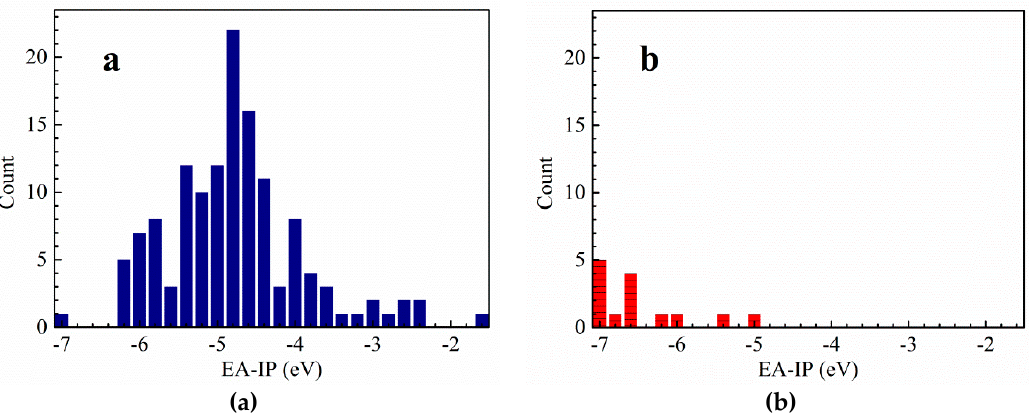
Figure 3. The di ff erence between VEA of the cation and VIP of the anion for common energetic salts ( a ) Figure 3. The difference between VEA of the cation and VIP of the anion for common energetic salts Figure 3. The difference between VEA of the cation and VIP of the anion for common energetic salts Figure 3. The difference between VEA of the cation and VIP of the anion for common energetic salts and cyclo -N 5 − salts ( b ) at DFT-B3LYP / 6-311 ++ G(d,p) level in ( a ) and cyclo -N 5 − salts ( b ) at DFT-B3LYP/6-311++G(d,p) level in water. ( a ) and cyclo -N 5 − salts ( b ) at DFT-B3LYP/6-311++G(d,p) level in water. ( a ) and cyclo -N 5 − salts ( b ) at DFT-B3LYP/6-311++G(d,p) level in water.